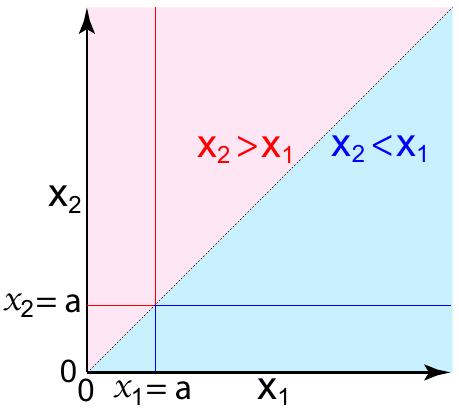
Figure 1. A portion of the state space of two positive real variables x 1 ∈ x 1 and x 2 ∈ x 2 (the space has no upper bound). The sub-spaces highlighted correspond to the propositions x 2 < x 1 (light blue), x 2 > x 1 (light red), x 1 = a , and x 2 = a . Exchangeability of x 1 and x 2 (Equation (14)) corresponds to symmetry of probabilities around the identity line x 1 = x 2 ; thus P ( x 2 < x 1 ) = P ( x 2 > x 1 ) ,